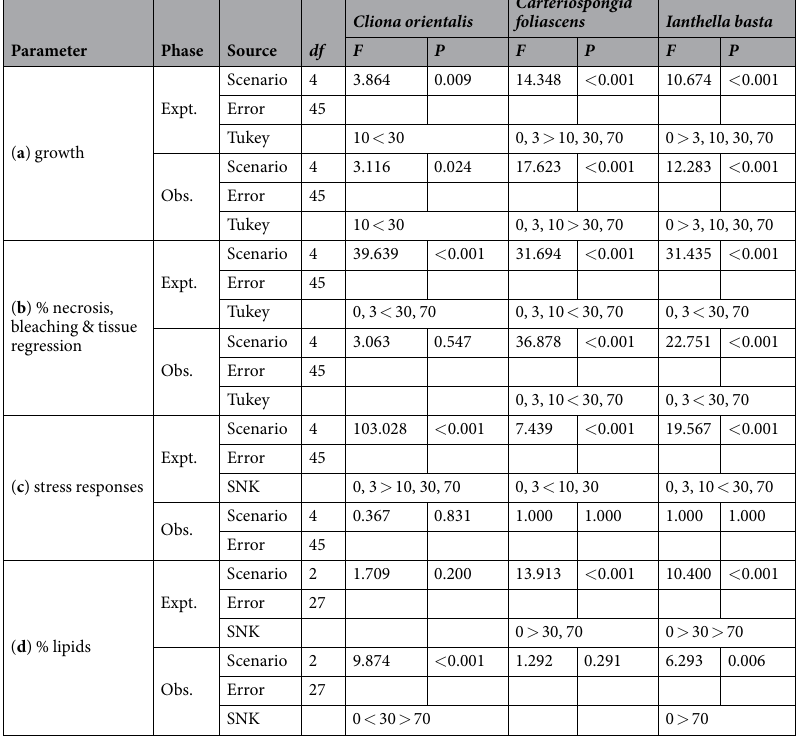
Table 3. Analyses of variance on the effects of dredging on the physiological responses of sponges. (a) One-way ANOVA on sponge growth (changes in biomass per unit area in C . orientalis , and relative growth rate based on surface area in C . foliascens and I . basta ), (b) One-way ANOVA on ranks of the percentage of necrotic, bleached and regressed tissue, (c) One-way ANOVA on percentage of open oscula in C . orientalis and on percentage of mucus coverage in C . foliascens and I . basta , (d) One-way ANOVA on the percentage of sponge biomass comprised of lipids, for each species separately, at the end of the experimental and observational phase. Tukey and Student Newman-Keuls (SNK) tests have been performed for significant pairwise multiple comparisons in a-b and c-d, respectively (scenarios: 0, 3, 10, 30 and 70